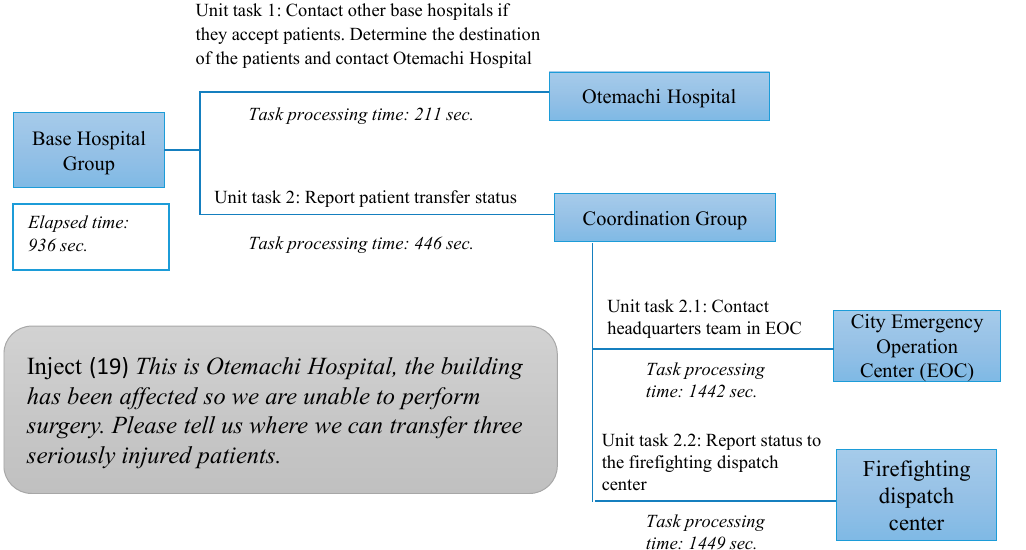
Figure 1. Communication network for inject code 19 of the October Disaster Medical Operation Center (DMOC) exercise.